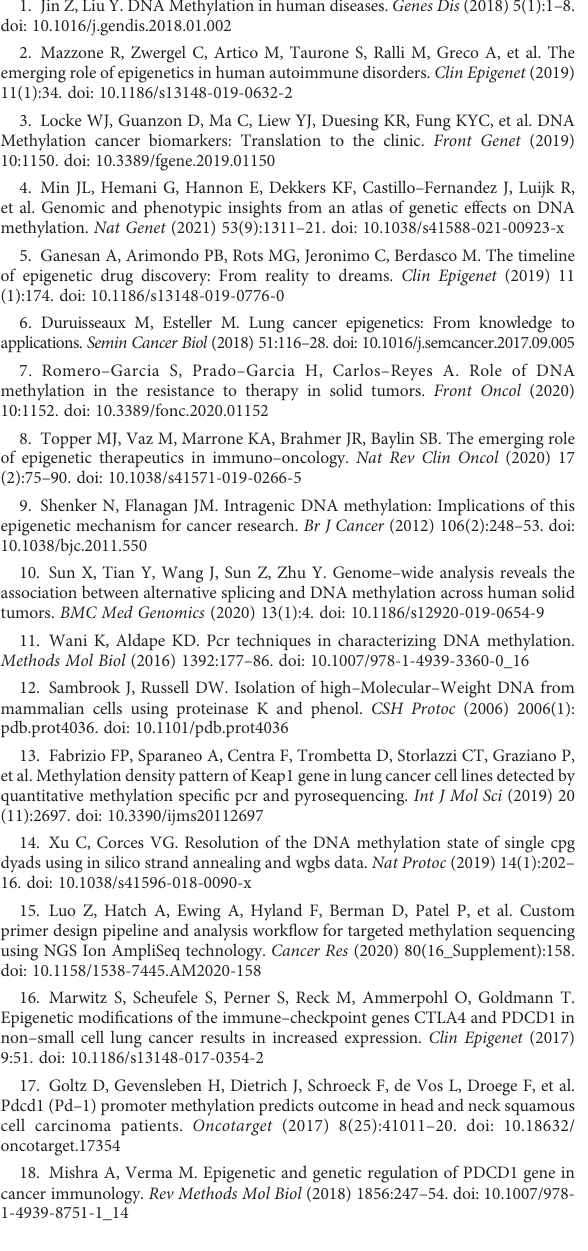
boxplot (Wilcoxon signed-rank test). SUPPLEMENTARY FIGURE 4 Strand speci fi c distributions of CpG methylation in samples using OPERA_MET-A panel at KEAP1 gene. The average percent of global CpG methylation (target_CpGs) in paired non-neoplastic and tumor tissues of FFPE samples 830, 881, 889. Global % CpG methylation at W strands is in light blue boxplots, at C strands in red